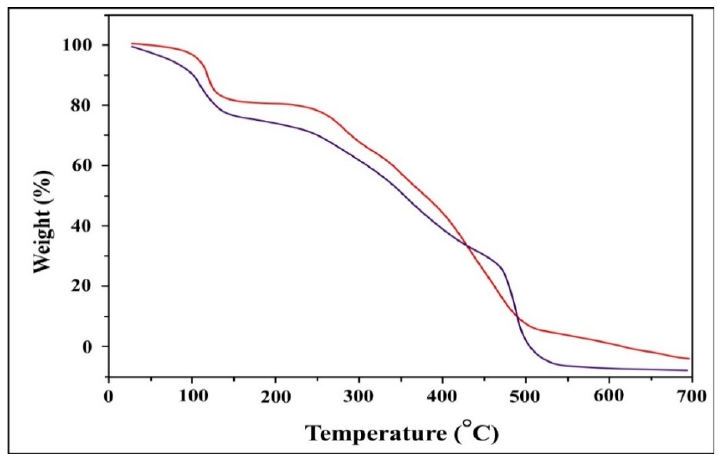
Figure 3. TGA curve of TIH (blue) and TIHP (red).